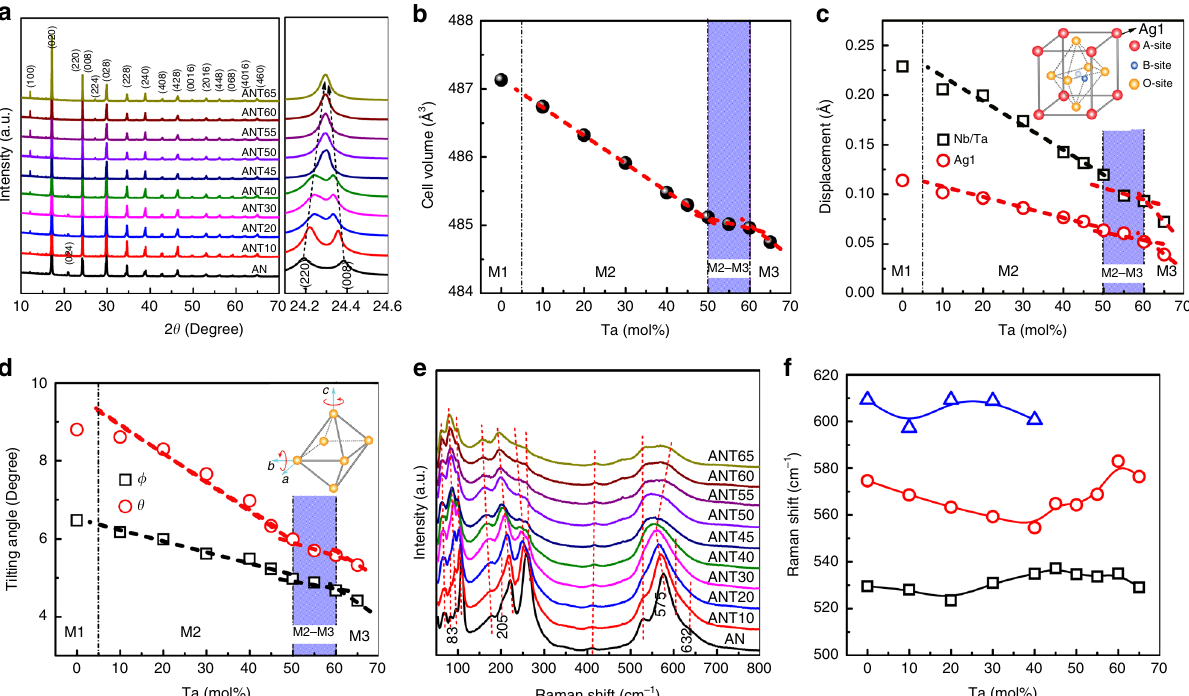
Fig. 5 SXRD and Raman spectra of ANT x ceramics. a SXRD of the as-prepared ANT x ceramic powders. The composition dependence of b cell volume, c displacement of Ag1 and Nb/Ta cations, and d the [Nb/TaO 6 ] octahedral tilting angles θ and Φ after re fi nement. e Raman spectra of the as-prepared ANT x ceramics, and f the fi tted Raman shifts for the peaks with wavenumber at 500 – 650 cm − 2